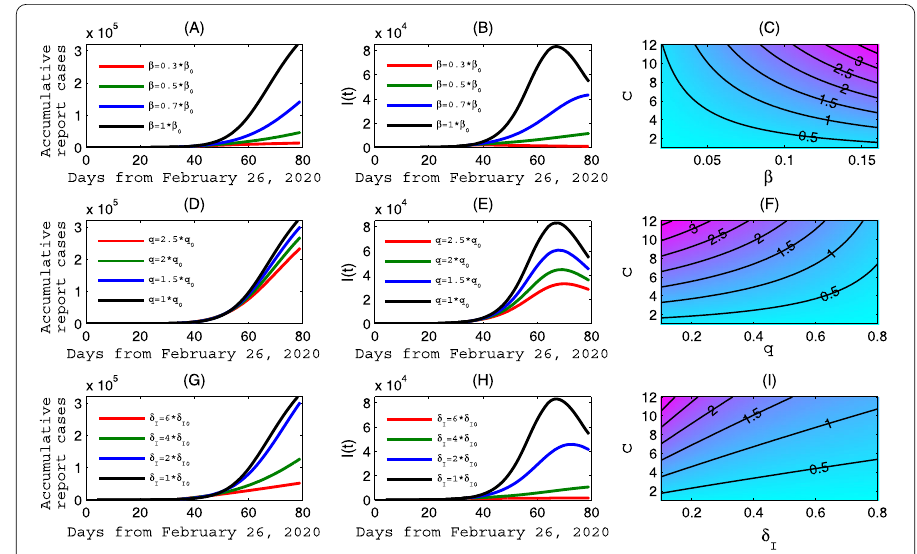
Figure 4 Sensitivity analysis. The impact of the transmission probability per contact β in ( A – B ), the quarantine rate q in ( D – E ), and the diagnose rate δ I in ( G – H ), respectively, on the COVID-19 epidemics of Ontario. ( C ), ( F ) and ( I ), Contour plots of the control reproduction number with respect to the contact rate c and the transmission rate β , or quarantine rate q , or rate diagnose rate δ I , respectively. Here, the baseline values of the parameters are fixed as the same as those in Fig. 3, β 0 , q 0 and δ I 0 denote the estimated